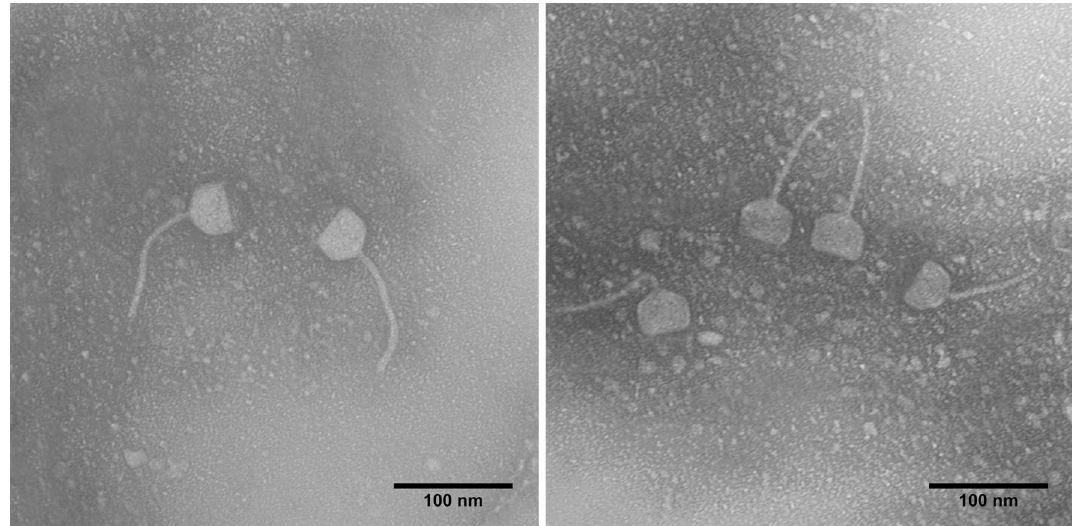
Figure 3. Electron micrograph of the vB_EfaS-SRH2 phage with pentagonal heads and flexible